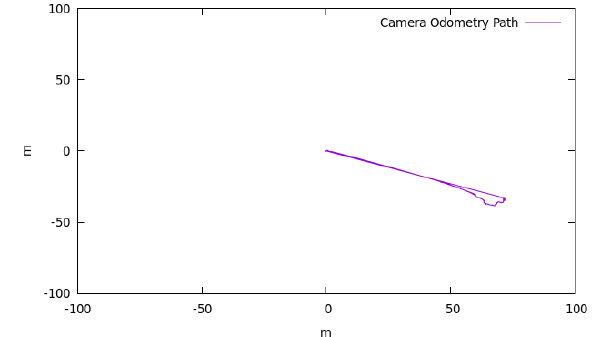
Figure 11. Zoomed out tracking path for free movement with calibrated camera.